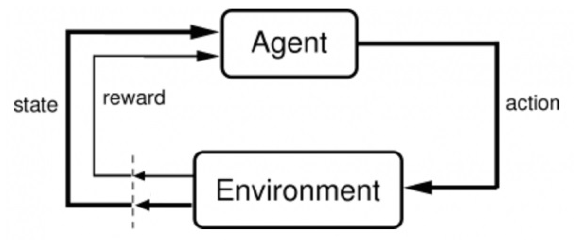
Figure 1. A schematic diagram of the reinforcement learning process.